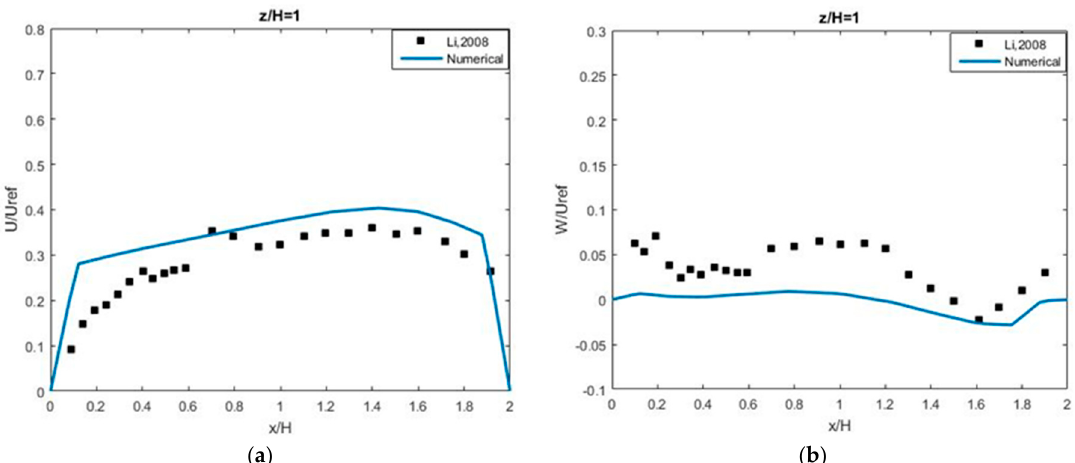
Figure 14. The horizontal profile of the normalized velocities U / U ref ( a ) and W / U ref ( b ) along a roof level line with AR = 0.5. Squares (Li et al. [9]), dash line (RNG).